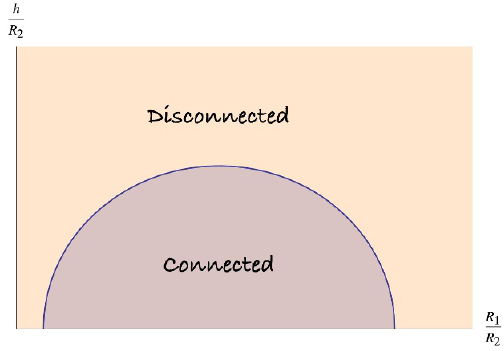
Figure 5 . The phase diagram for two loops of opposite